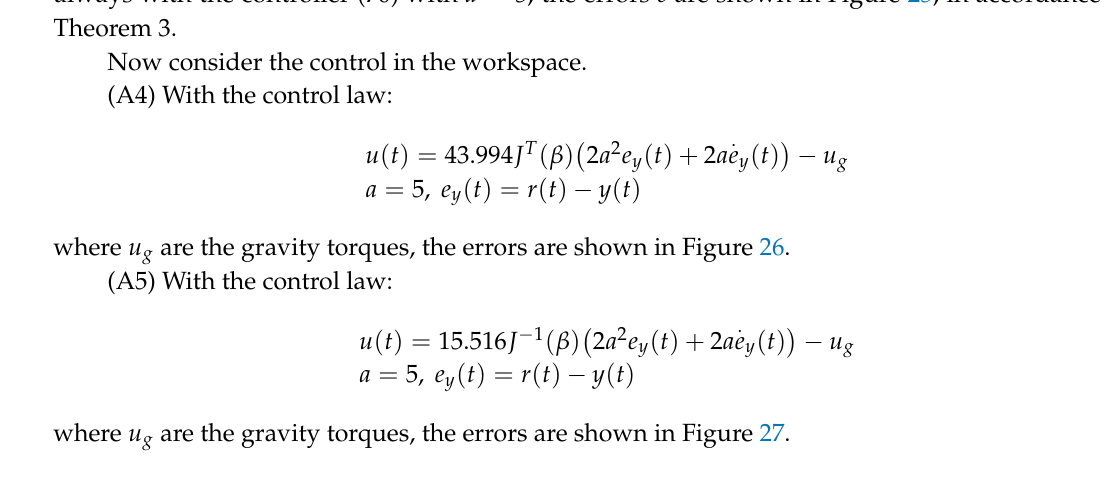
Figure 24. Time histories of the errors using the controller (70) with a = 5 .